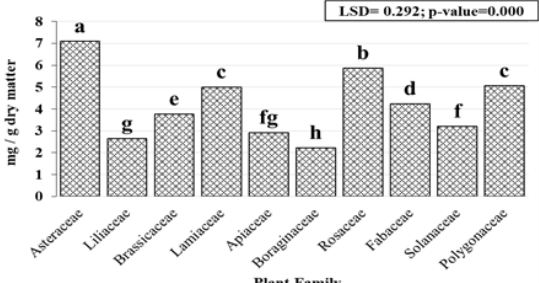
Fig. 13. Mean value of accumulation of flavonoid compounds in the plant family regardless of plant species (mg/g dry matter equivalent to mg quercetin / dry matter). Table 3. Correlation between measured traits DPPH FRAP TAC ABTS